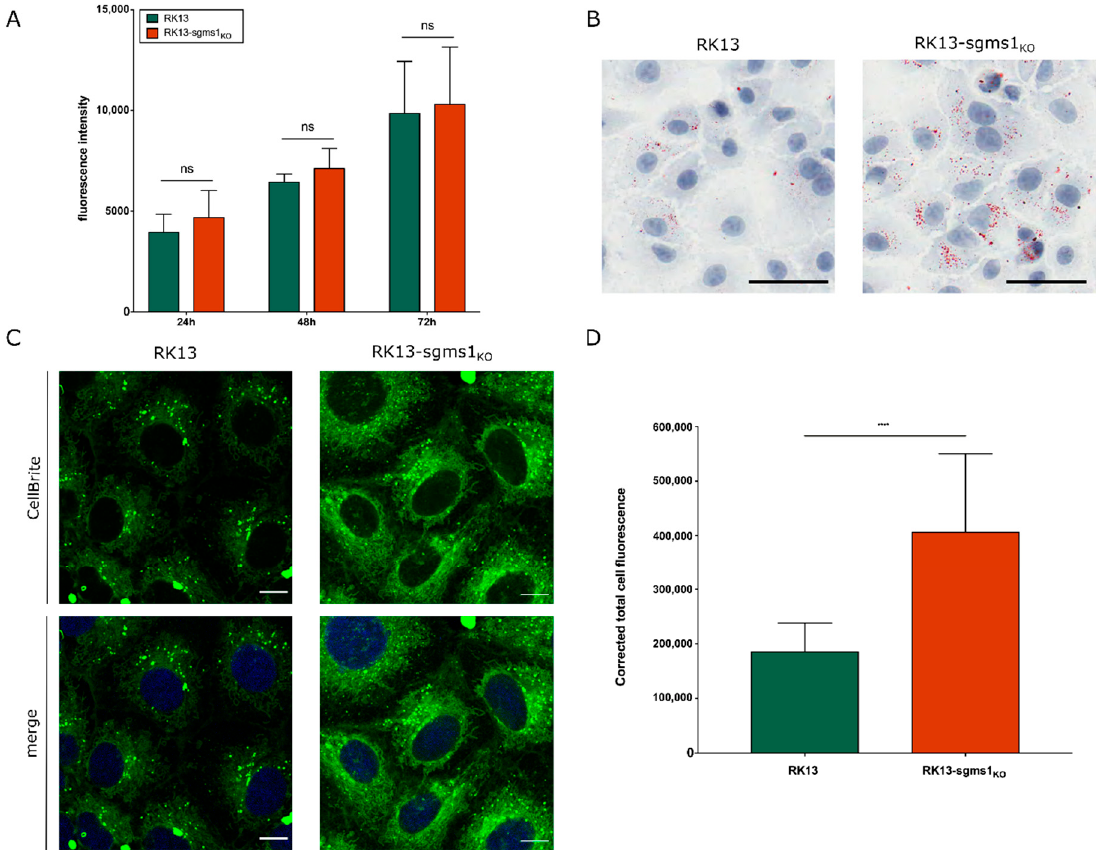
Figure 3. Characterization of RK13-sgms1 KO cells. SMS1 knockout cells were compared to parental RK13 cells. Cell viability and propagation was measured at 24, 48 and 72 h post seeding using the PrestoBlue TM reagent ( A ). Shown is the mean of three independent experiments. Differences in the lipid metabolism were detected by Oil Red O staining (red) showing an accumulation of lipids in RK13-sgms1 KO cells compared to parental RK13 cells ( B ). Nuclei were counterstained with Hematoxylin and scale bars indicate 50 µ m. ( C ) Cytoplasmic membranes were stained with CellBrite TM for 24 h. Nuclei were counterstained with DAPI, and fluorescence was detected with a confocal laser-scanning microscope with constant settings. Scale bars indicate 10 µ m. ( D ) Fluorescence was quantified by calculation of the corrected total cell fluorescence. Significant differences were calculated by two-way ANOVA followed by Sidak’s multiple comparison test ( A , ns: not significant) or by an unpaired t -test ( D , **** ≤